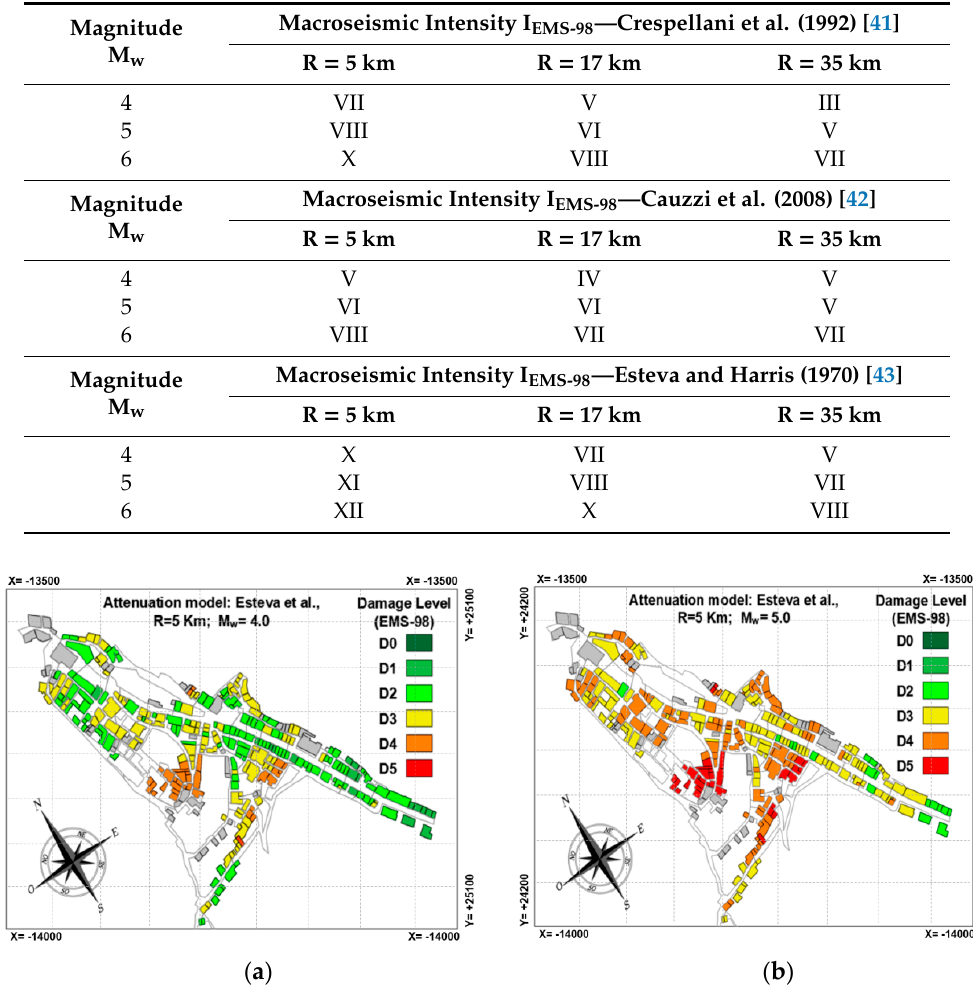
Table 3. The correlation between moment magnitude, M w , and macroseismic intensity, I EMS-98 .